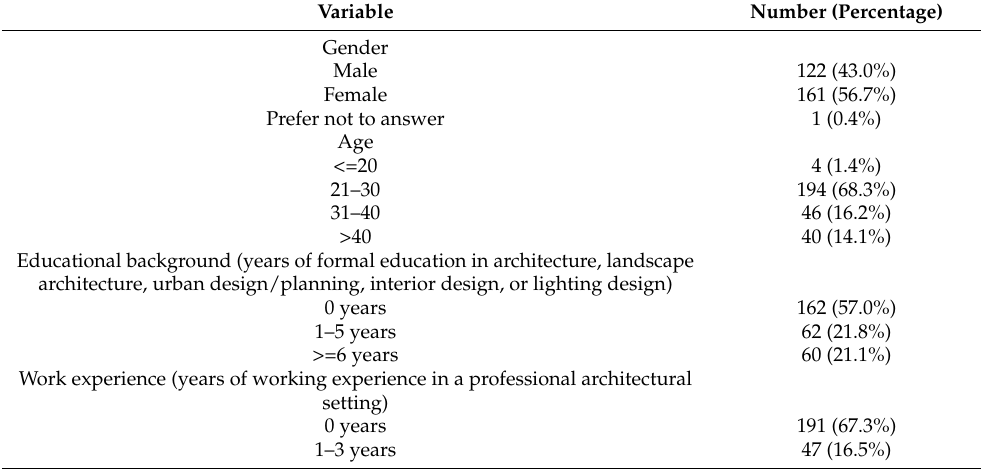
Table 2. Characteristics of the study population.